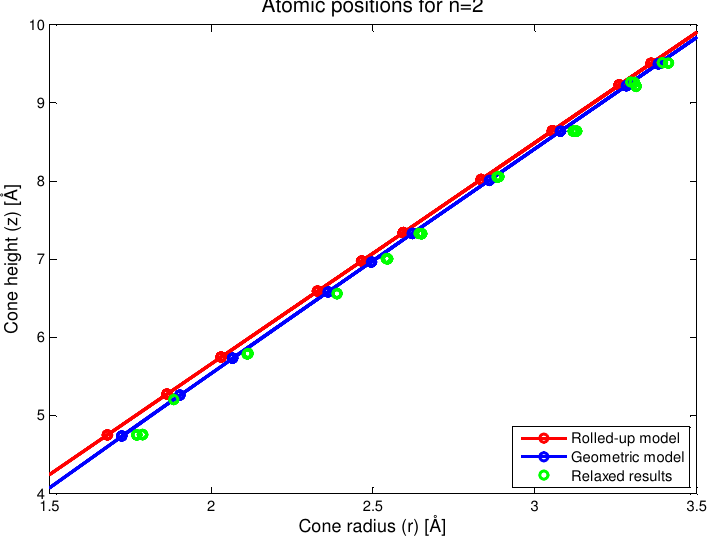
Figure 5. Atomic positions as predicted by the rolled-up, new geometric and simulation